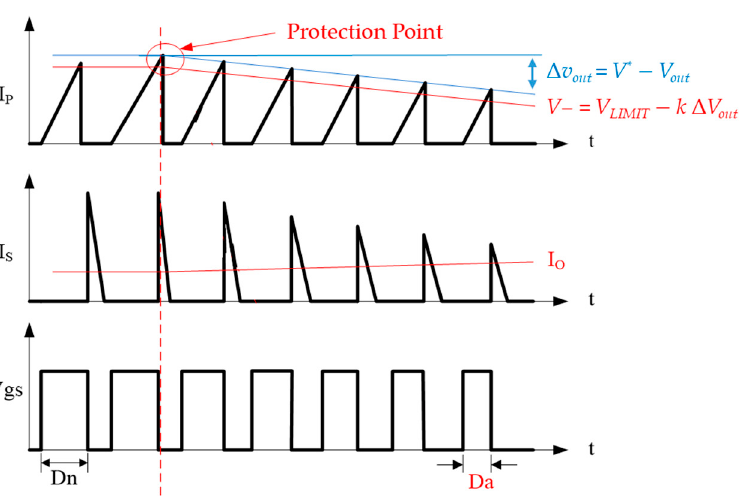
Figure 3. Waveform diagrams of a primary-side controlled flyback with FBC control working in DCM.